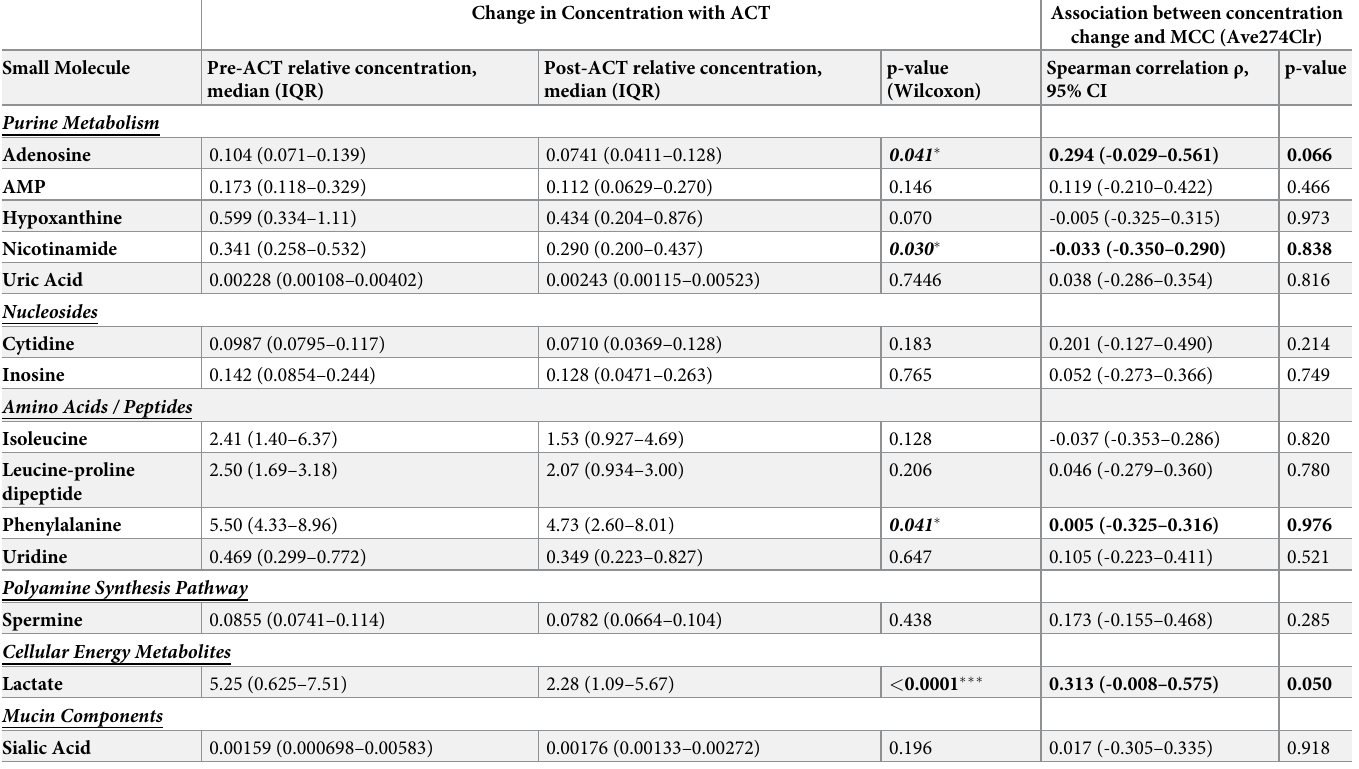
Table 2. Relative concentration of small molecules analyzed from exhaled breath condensate.